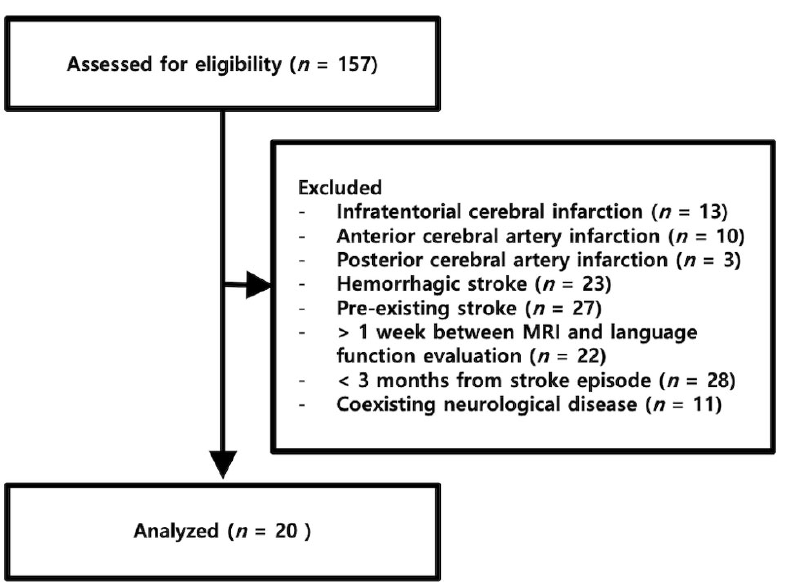
Figure 1. Flowchart of the study process. Flow diagram depicting the reasons for exclusion among the patients assessed for eligibility.